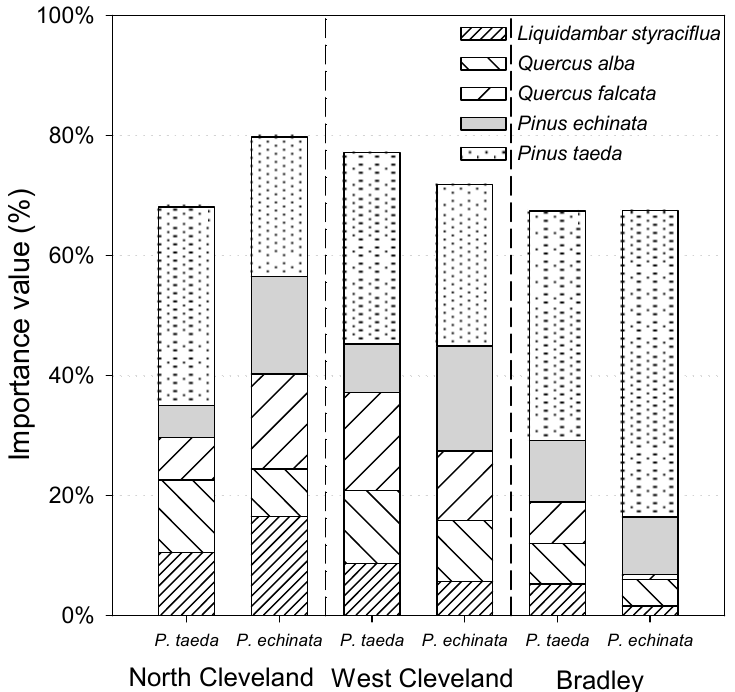
Figure 1. Mean importance value (%) of the five most abundant competitor species in the neighborhoods of shortleaf ( Pinus echinata ) and loblolly pine ( Pinus taeda ) across three mature, natural-origin, pine–hardwood stands in southeastern Arkansas (separated by dashed line).